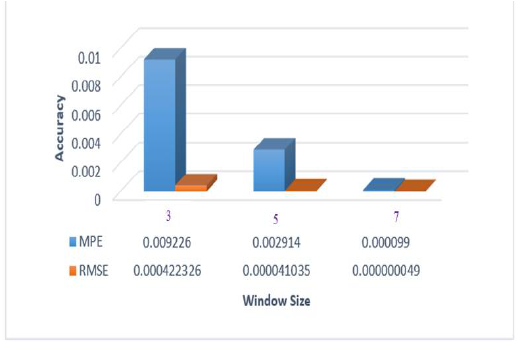
Figure 3 The effect of different window sizes in using the moving average smoothing